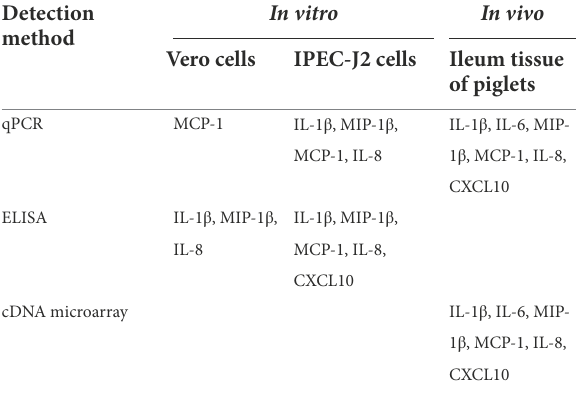
TABLE 3 Comparison of the different in cytokine profiles in vitro and in